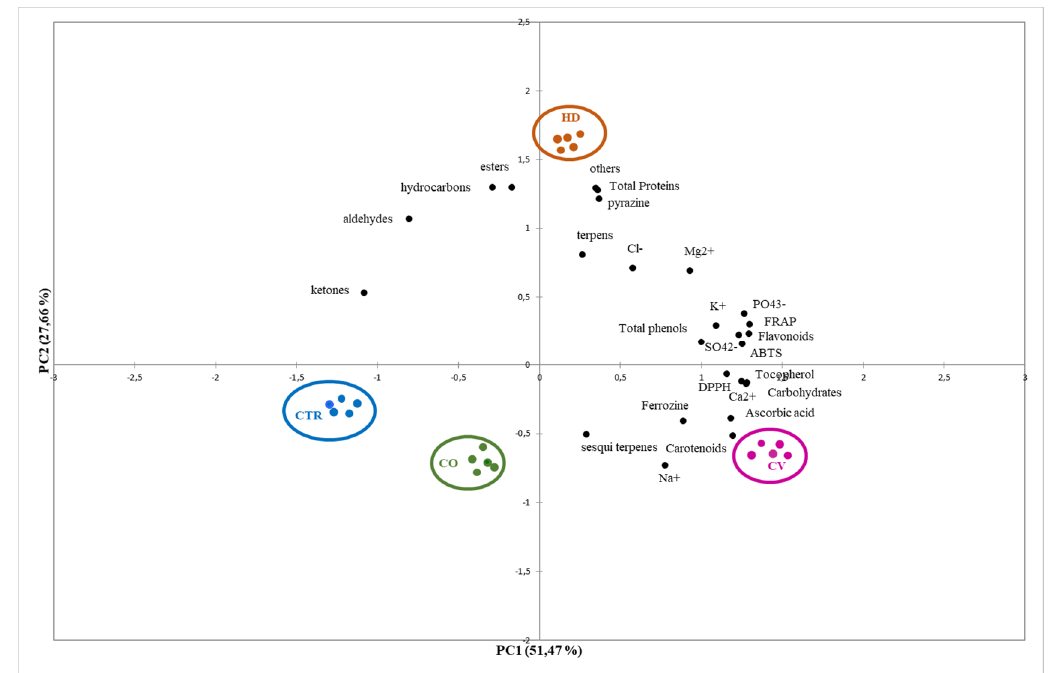
Figure 5. PCA Bi-plot for data fusion of red Topepo